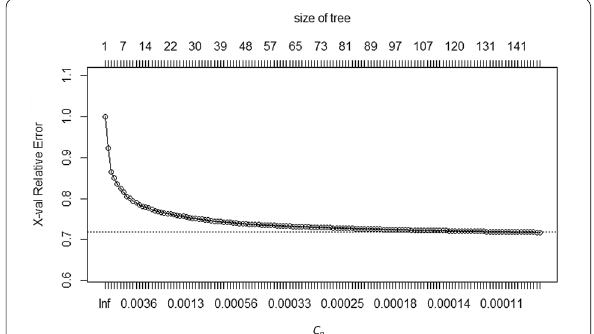
Fig. 3 Improvement of C p s with the reduction of relative errors and increasing size of the